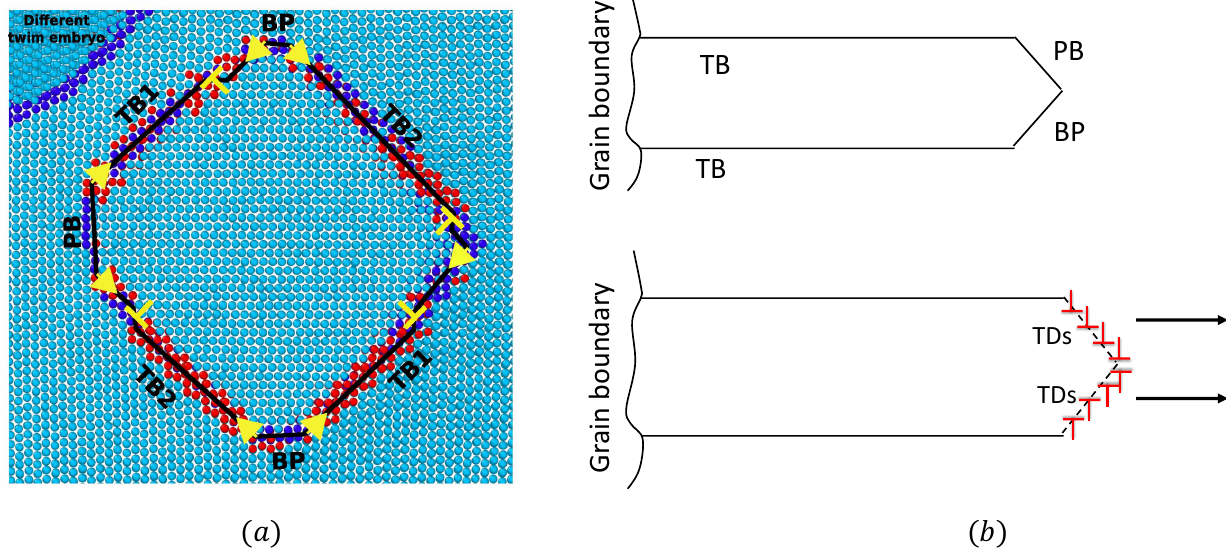
Figure 16. ( a ) Atomistics simulation showing an octagonal diamond–shaped morphology for a stable twin nucleus, and ( b ) a schematic for a rapid lengthwise growth of a twin across a parent grain as a result of a highly unstable PB/BP boundary that becomes highly glissile twinning diconnections moving rapidly across the